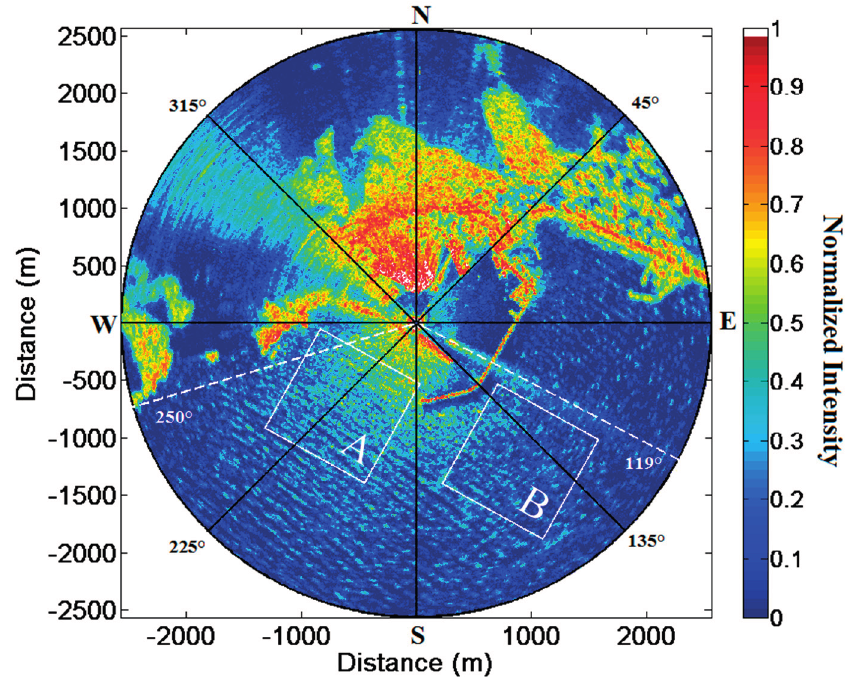
Figure 3. A sample image of the raw radar data